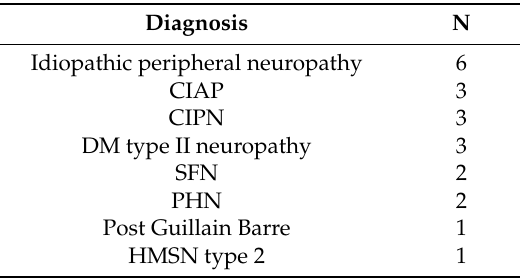
Table 1. Diagnosis.